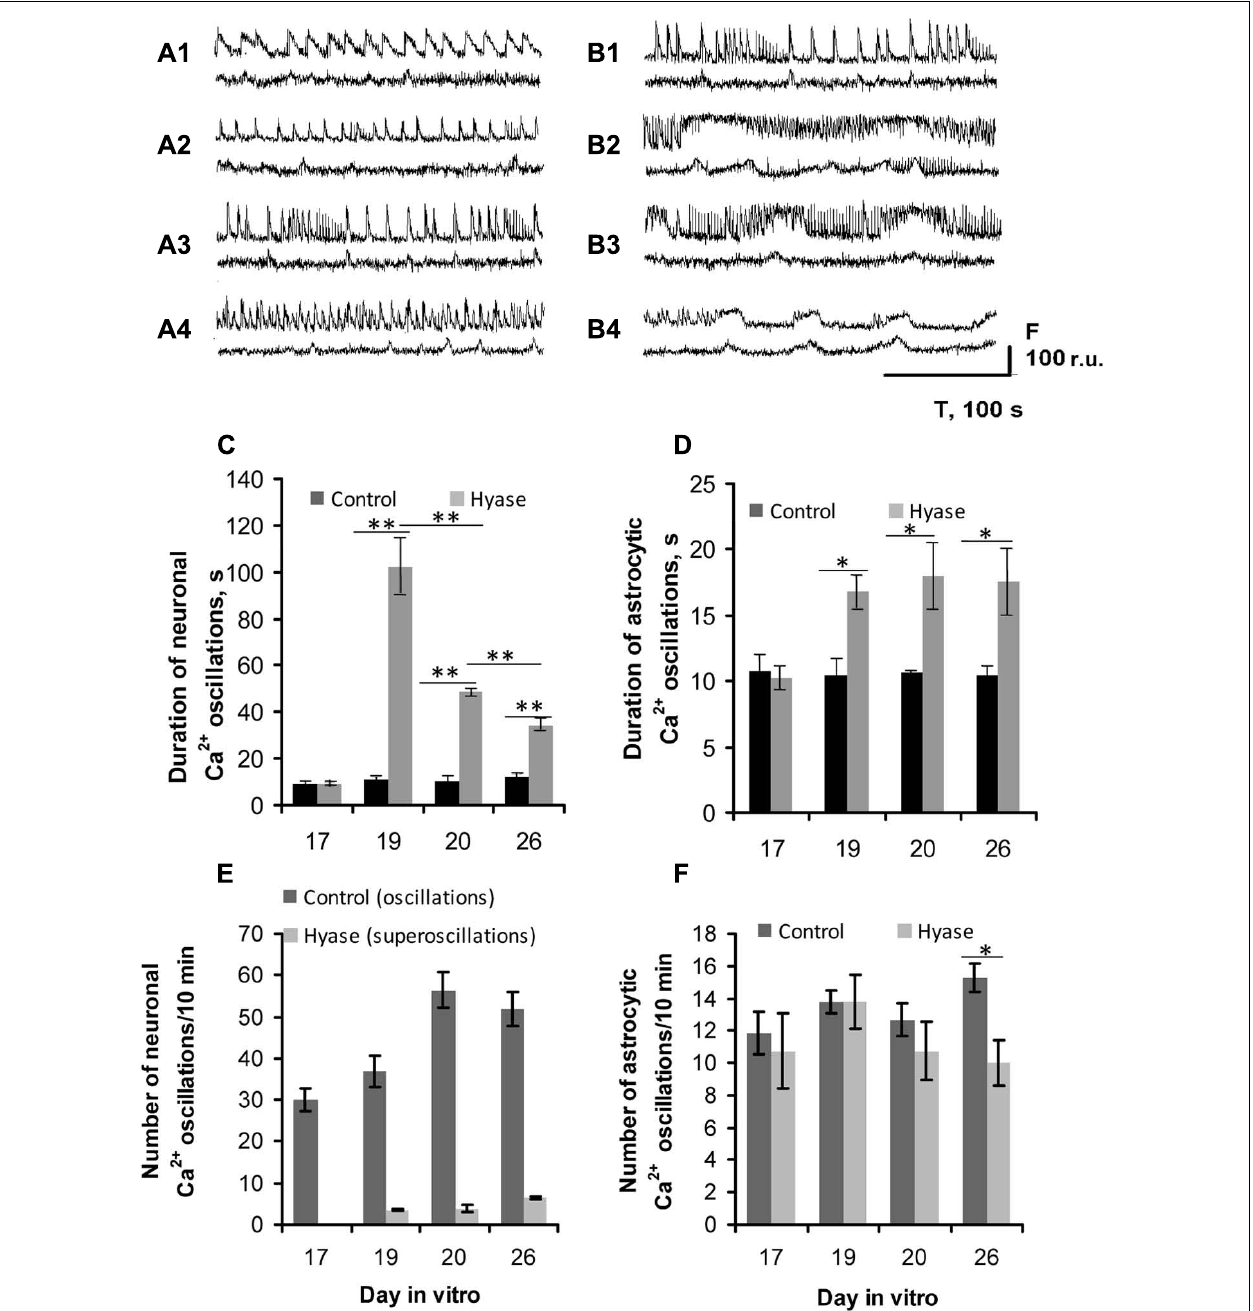
oscillation duration after Hyase application. (D) Time-course of the changes in the astrocytic Ca 2 + oscillation duration after Hyase application. (E) Number of neuronal and (F) astrocytic Ca 2 + oscillations after Hyase application. Neuronal Ca 2 + superoscillations appear 2 days after the Hyase treatment on DIV 19, and there is no such activity in the control cultures.There is no difference between the Control and Hyase groups in the frequency of astrocytic Ca 2 + oscillations before DIV 26, but they differ on DIV 26 (Control 15.75 ± 0.89, Hyase 10.3 ± 0.9, ANOVA; p < 0.05; N = 5).The astrocytic Ca 2 + oscillations after Hyase treatment become less frequent but longer. * p < 0.05; ** p < 0.001 indicate significant differences by ANOVA, N =